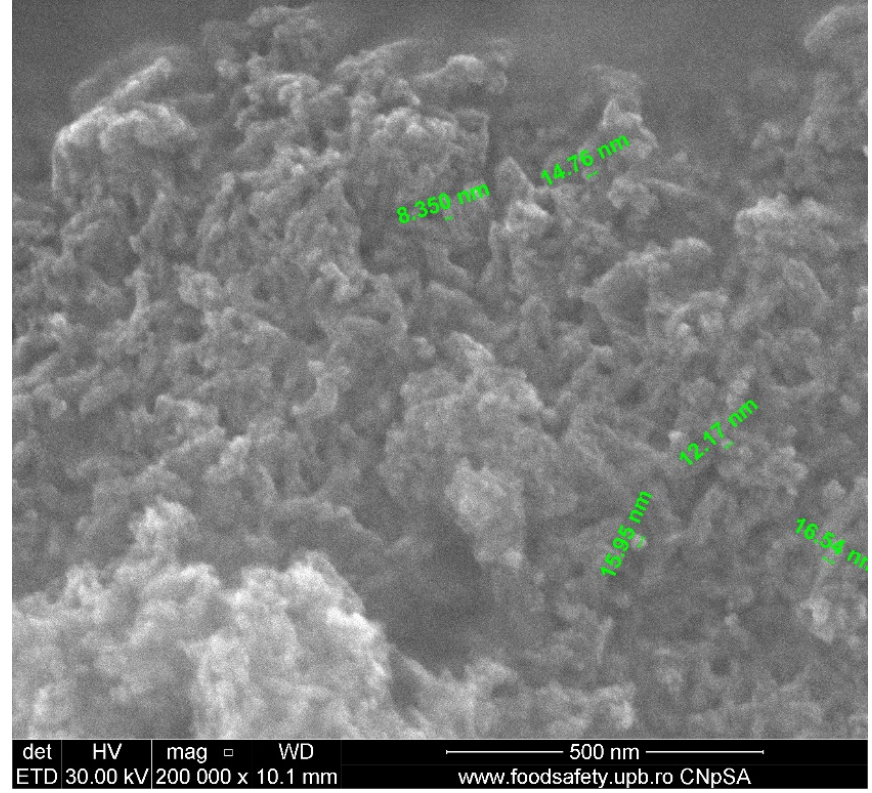
Figure 5. SEM image of pure HAp.